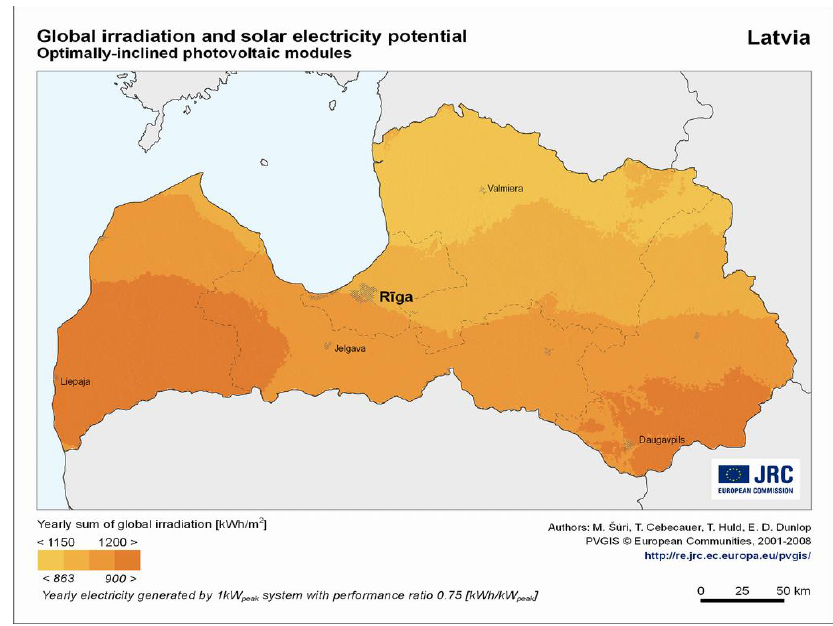
Fig. 2. Solar radiation and solar potential in Latvia